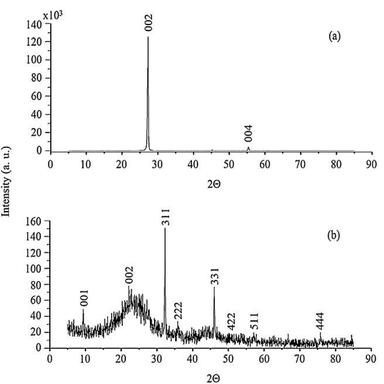
XRD patterns of (a) graphite and (b) GO-MnFe2O4/VAC.